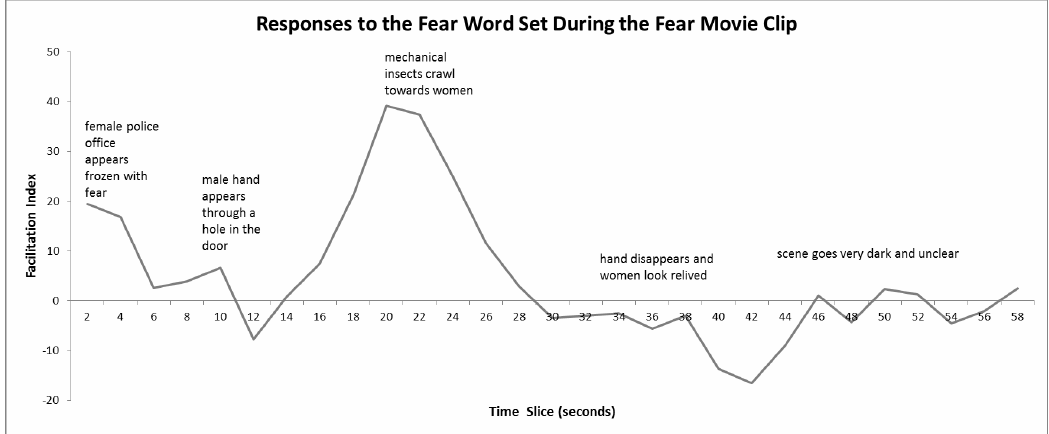
Figure 3. Three-point moving averages of facilitation indices for the Fear word set whilst viewing the Fear movie clip. Positive scores indicate fear, negative scores indicate fear opposite (serenity). A brief description of the content is shown at various points in time. Analysis indicated that the facilitation indices at the seconds 2, 4, 18 − 26, and 42 are significantly different from zero (in each case p < 0.05).